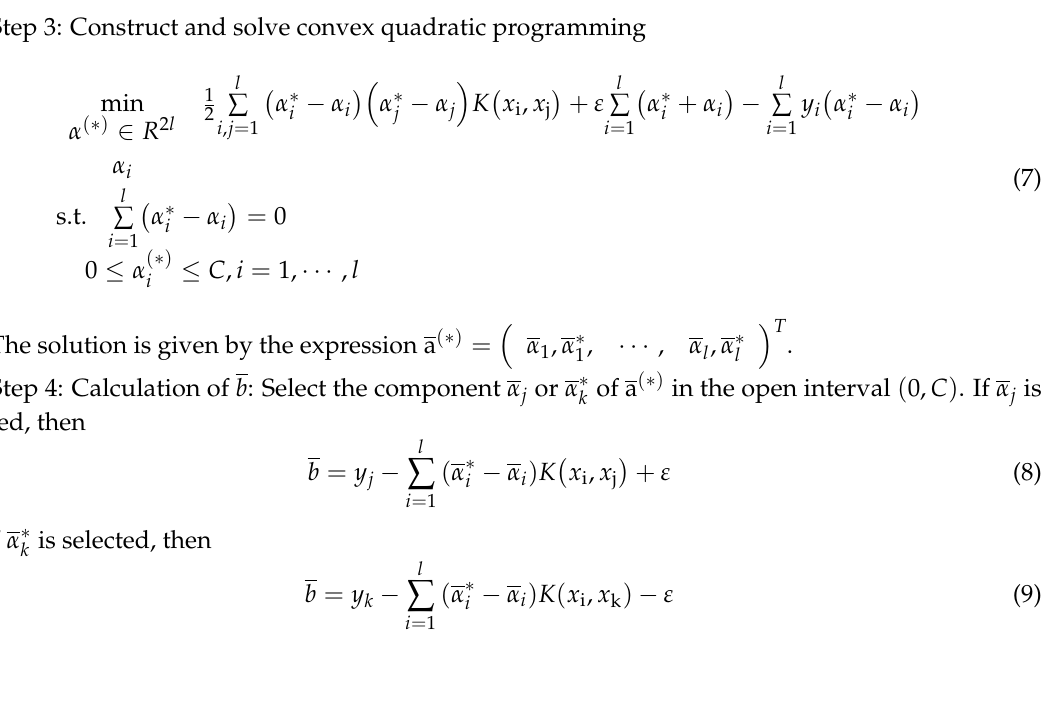
Figure 2. Insensitive loss function.